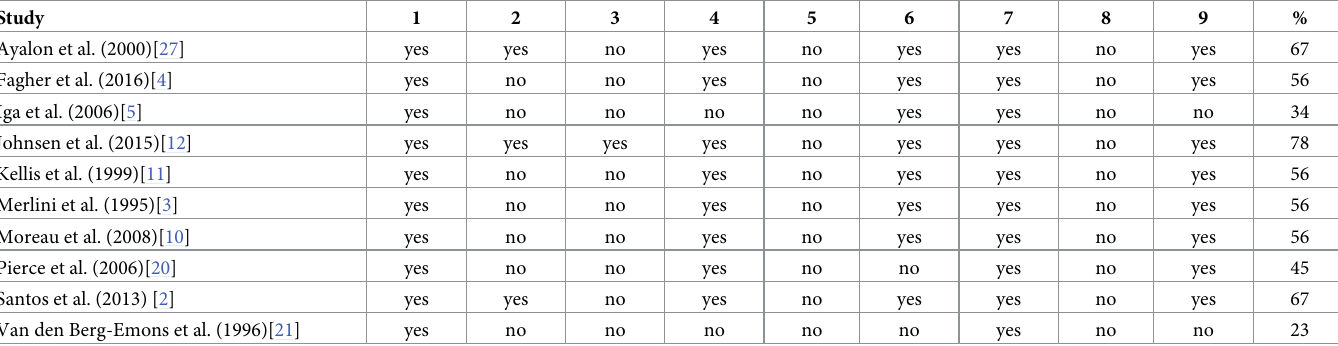
Table 1. Evaluation of the quality of the studies with clinical evaluation tool (CAT). Study